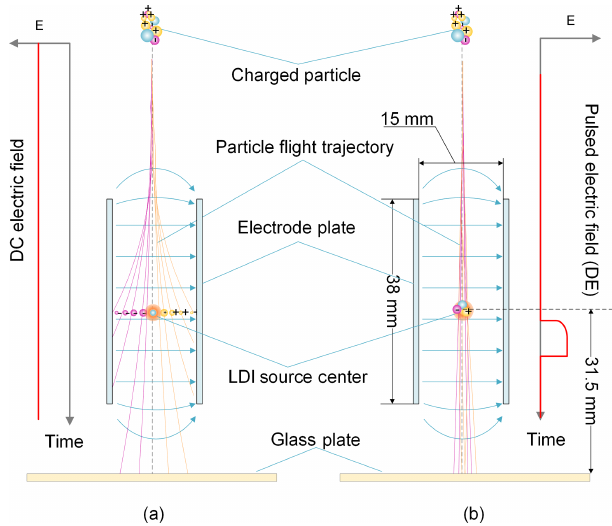
Figure 1. Experimental setup. The glass plate position and extrac- tion region dimensions are shown for two cases: (a) stationary elec- trical field extraction and (b) delayed